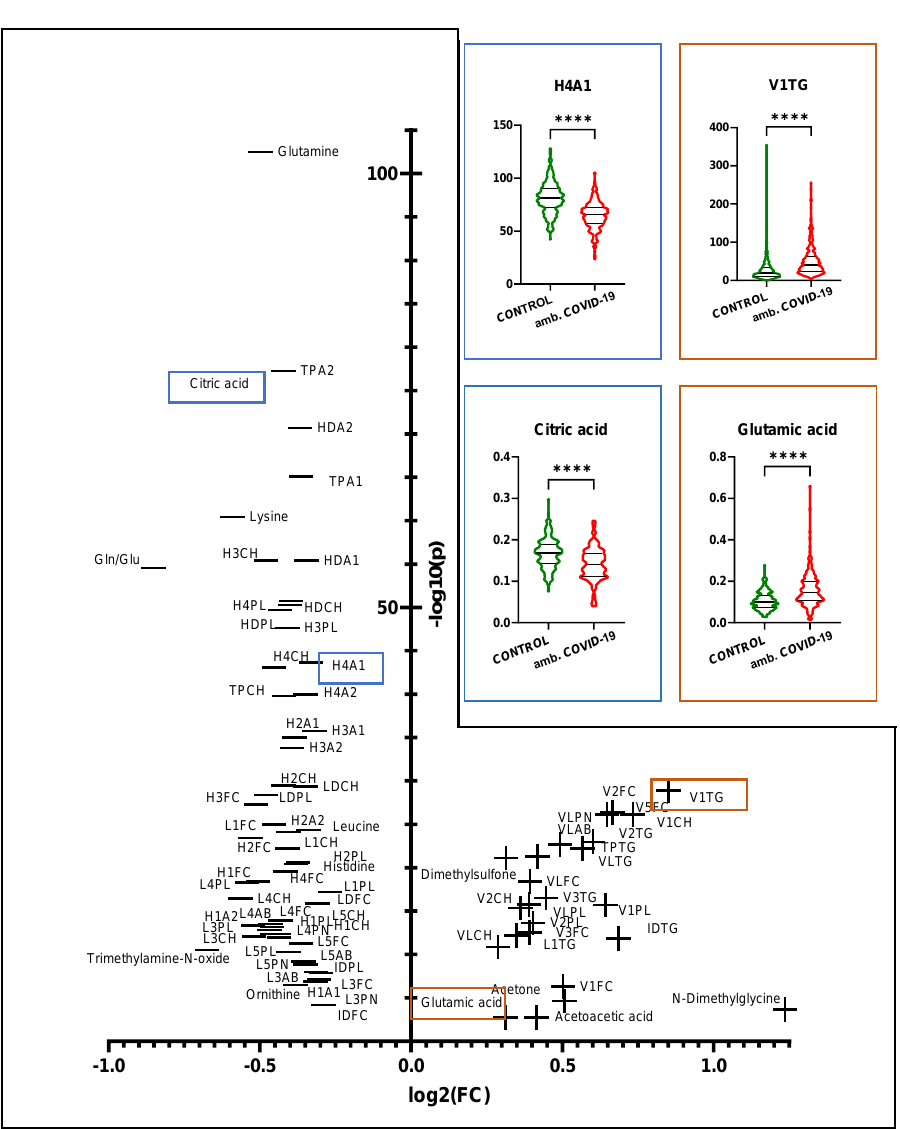
Figure 3. Volcano plot showing the univariate comparison of the COVID-19 patients who were not admitted to the hospital with the healthy controls. The logarithmized fold change (FC > 1.2) is plotted on the X-axis, whereas the Y-axis indicates the significance in the form of the logarithmized p -value (FDR p < 0.05). In the upper right, exemplary violin plots show the differences in significantly altered parameters. Four asterisks indicate a p -value of